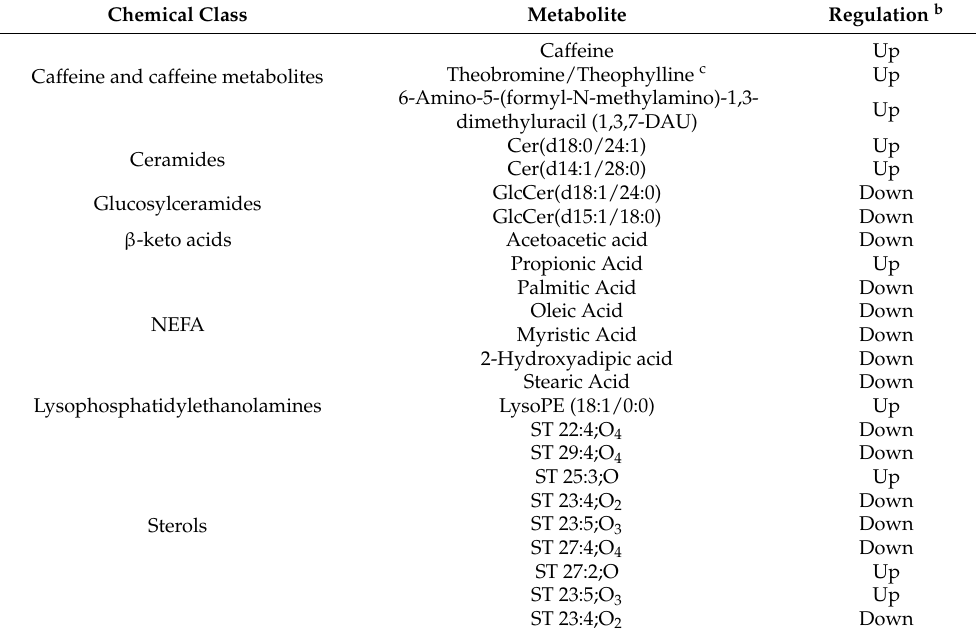
Table 3. Main discriminant metabolites a in the milk of goats fed SCG vs. control, detected in the negative ionization